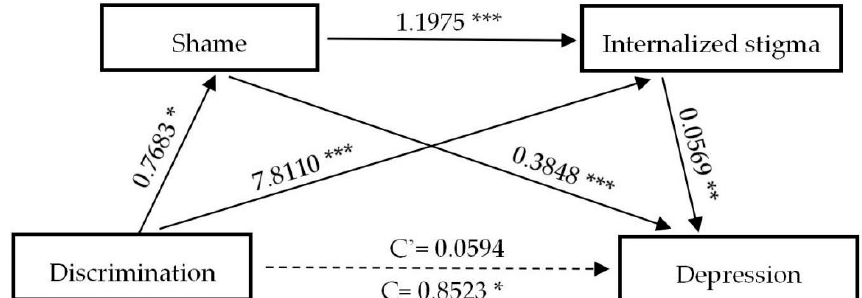
Figure 3. A serial mediation analysis of shame and internalized stigma on discrimination to depression. * p < 0.05, ** p < 0.01, *** p < 0.001.